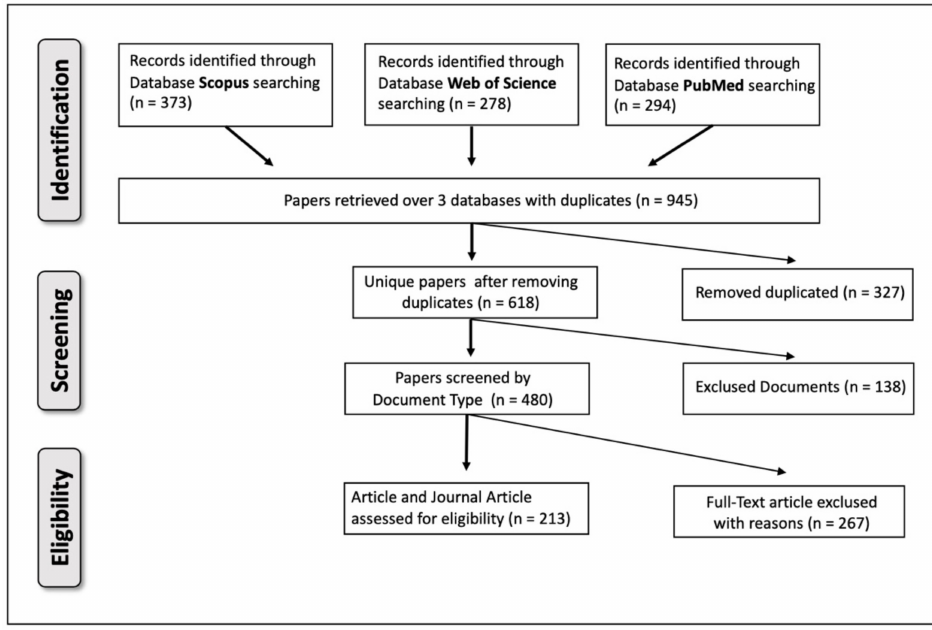
Figure 1. Flow diagram showing the algorithm of selection of eligible studies included in the SLR. The search process was carried out until 20 May 2022.